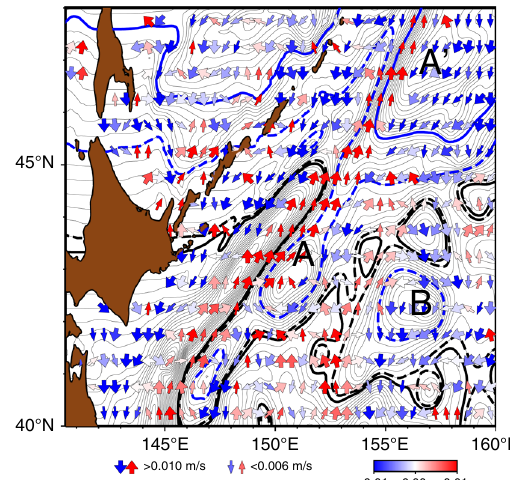
Fig. 8 Implication of meridional barotropic fl ows over topography by tracking eddy propagation. Vectors denote eddy propagation velocity derived by tracking eddies retrieved from satellite SSH 53 (see Methods). Color scale indicates the meridional propagation speed, where red (blue) denotes northward (southward). Characteristics Q c ¼ β y þ ψ Ta analyses of eddy propagation from satellite SSH 34 , imply that meridional propagation of eddies may be caused by ambient barotropic fl ows. Contours denote Q c (contour interval 0.5 × 10 − 6 s − 1 ) with thick lines of 4.5 (solid black), 5.0 (dashed black), 8.0 (dashed blue), and 12.0 (solid blue) × 10 − 6 s − 1 . Topographic rises A , A ′ , and B are